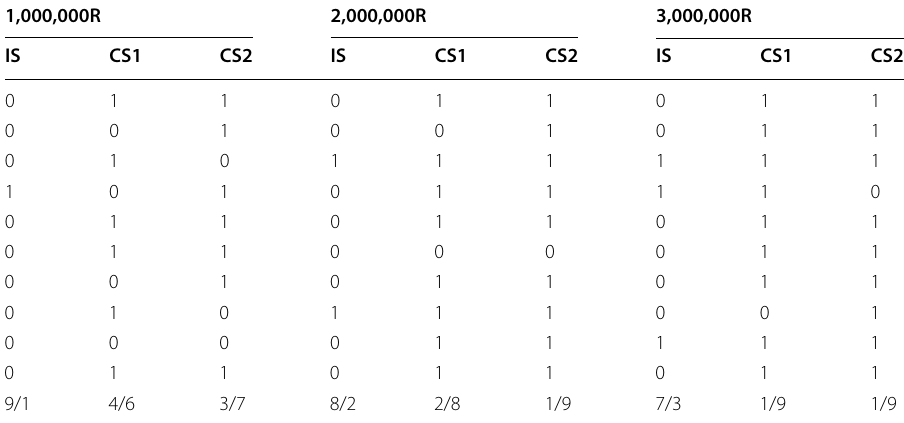
Table 3 Hacking using NoSQL-injection method; success (1) and failure (0) for IS, CS1 and